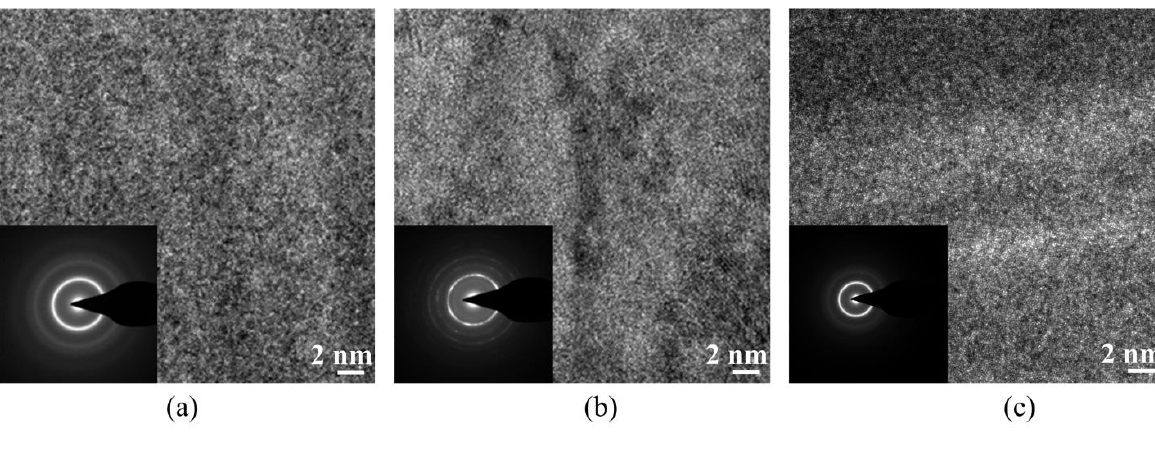
Figure 3. HRTEM images with selected area of diffraction (SAD) insets. ( a ) FeNiB thin film with 9.2 at% B, ( b ) FeNiAl thin film with 26.9 at% Al and ( c ) FeNiMo thin film with 11.3 at%